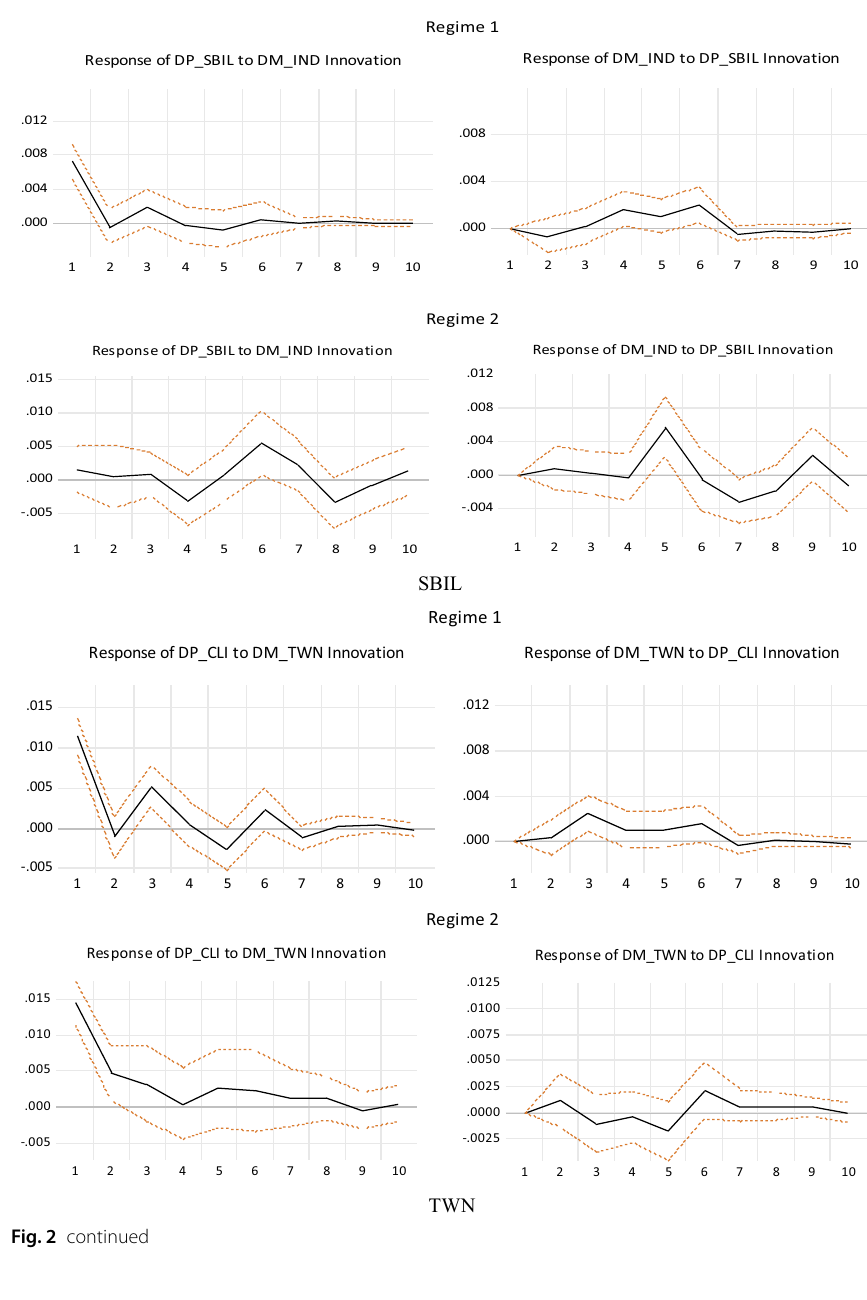
to Indian futures for the COVID-19 risks. Regarding the impact of the COVID-19 risks on the market returns (ε dc ↑→ dm ) , the safe haven characteristics of the 2nd period shock decrease over time, and the effects of the 6th and 12th periods gradually increase. Regarding the impact of market risk shocks on futures returns ( ε dm ↑→ dp ) , only the 6th period shock has a positive effect; Thus, TWN futures is a safe haven for COVID-19 and the market risks. Based on the above results in India and Taiwan, it can be concluded that futures returns are a safe haven during